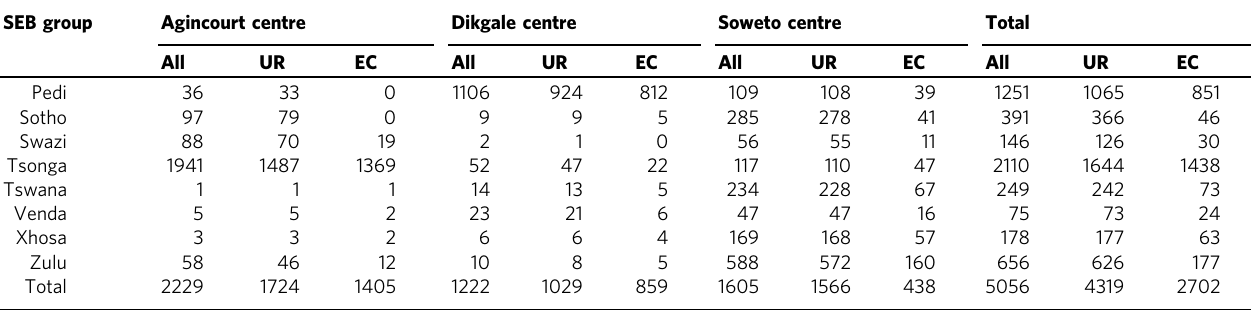
Table 1 Distribution of the South-Eastern Bantu-speaking (SEB) group by centre and ethnicity. SEB group